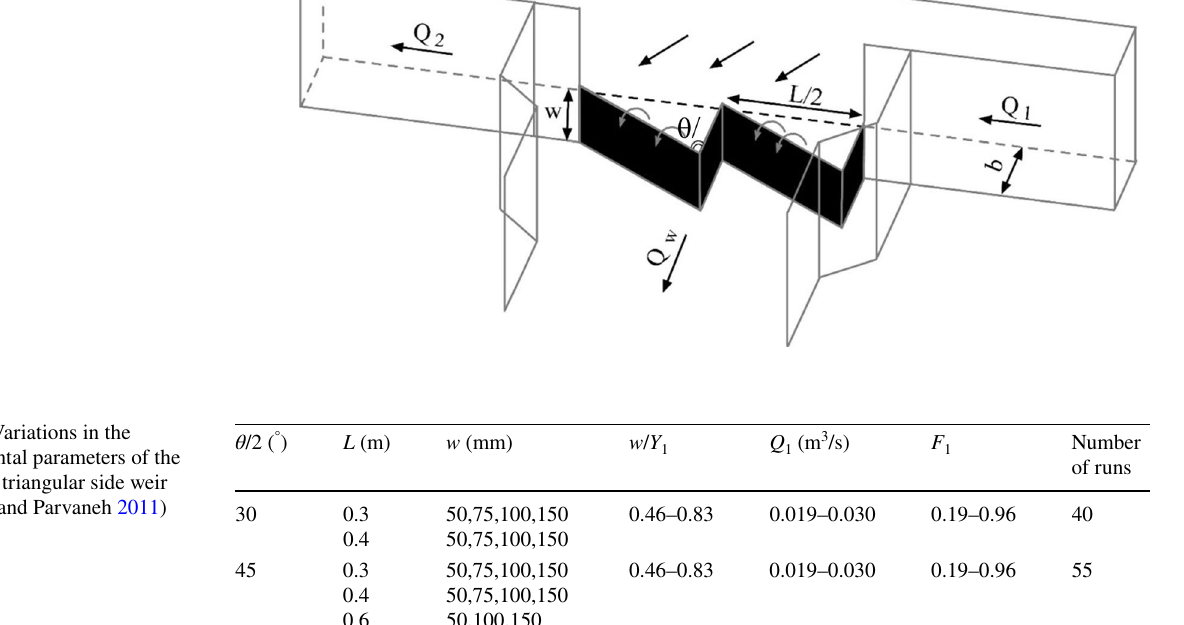
Fig. 1 Schematic overview of the improved triangular side weir (Borghei and Parvaneh 2011)